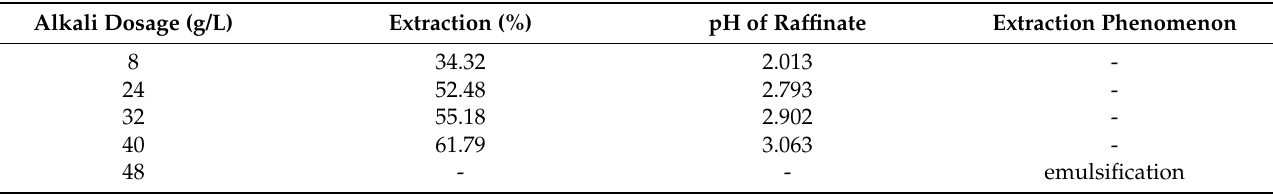
Table 5. The effect of alkali dosage on zinc extraction at acid dosage at 52 mL/L. Alkali Dosage